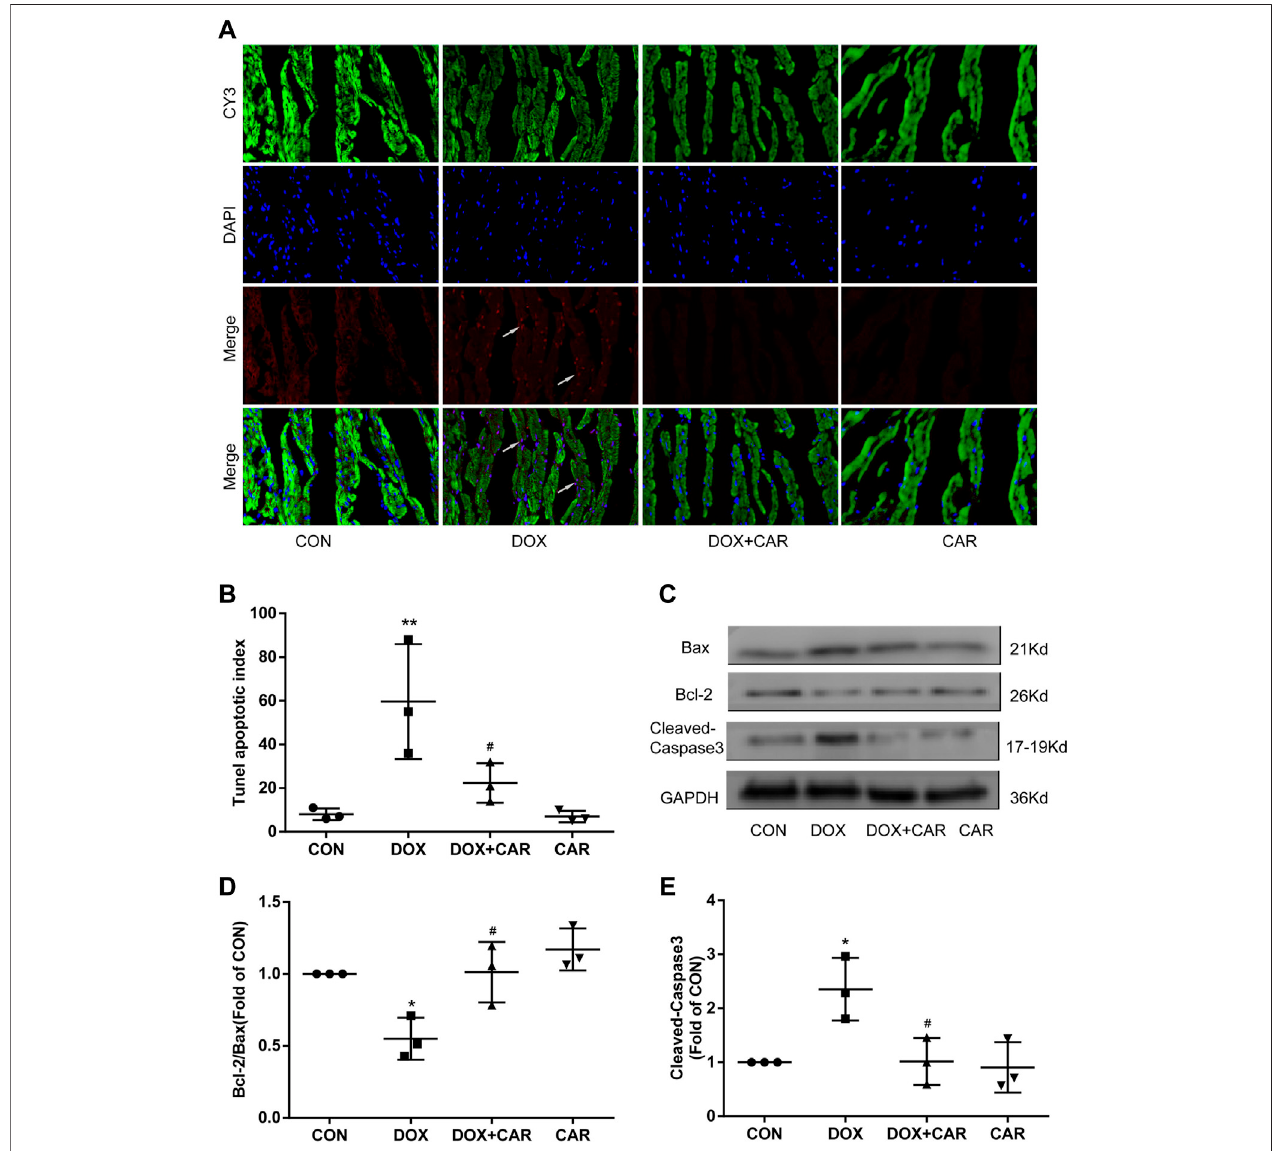
FIGURE 5 | CAR inhibited cardiomyocyte apoptosis induced by DOX. (A) : Representative pictures of the TUNEL assay, (B) : Histogram representing quantitative analysisoftheapoptoticindex, (C) :RepresentativewesternblotsofBcl-2,BaxandCleaved-Caspase-3, (D) :Histogramrepresentingthequantitativeanalysisoftheratio ofBcl-2/Bax, (E) :HistogramrepresentingthequantitativeanalysisofCleaved-Caspase-3.Quantitativedataaremeans±SEM(n=3).* p < 0.05,** p < 0.01vs.CON;# p < 0.05 vs. DOX.